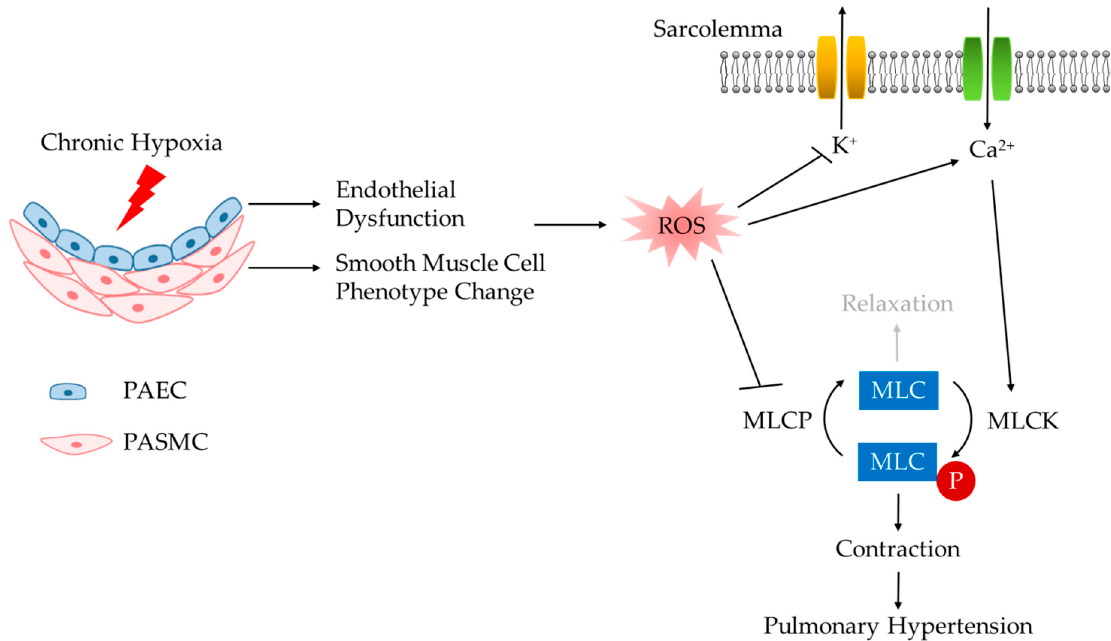
Figure 1. Enhanced vasoconstriction resulting from chronic hypoxia-induced functional alterations of endothelial and smooth muscle cells contributes to pulmonary hypertension. PAEC, pulmonary arterial endothelial cell; PASMC, pulmonary arterial smooth muscle cell; ROS, reactive oxygen species; MLCK, myosin light chain kinase; MLCP, myosin light chain phosphatase; MLC, myosin light chain.